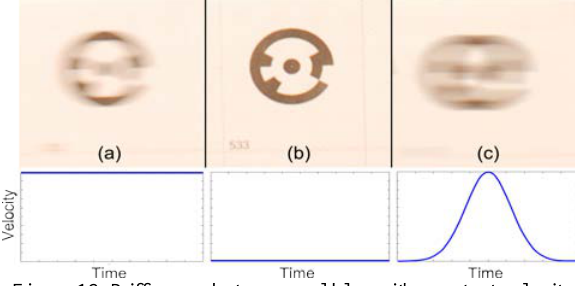
Figure 12. Difference between real blur with constant velocity (a), still image (b) and simulated MATLAB blur with acceleration (c).